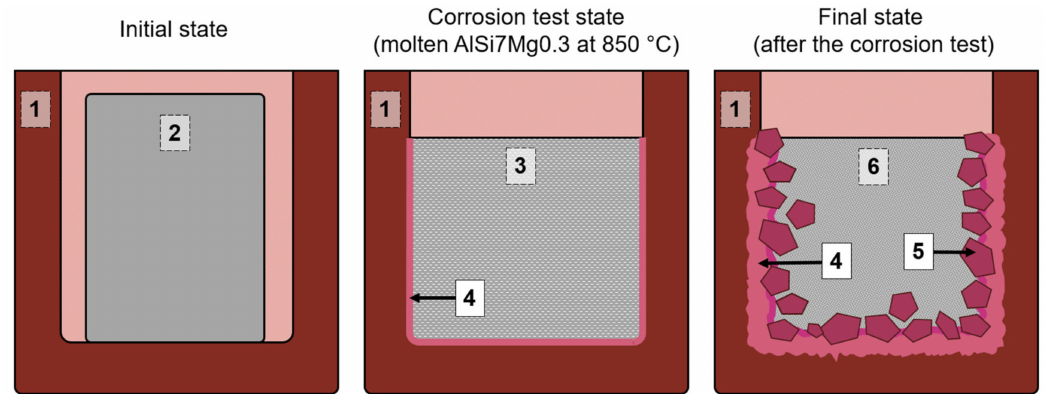
Figure 2. Schematic diagram of the crucible corrosion test: (1) crucible made from the steel–MgO composite, with an outer diameter of 50 mm; (2) solid aluminum alloy; (3) molten aluminum alloy; (4) crucible–aluminum alloy contact interface; (5) corrosion products; (6) solidified aluminum alloy after corrosion test.